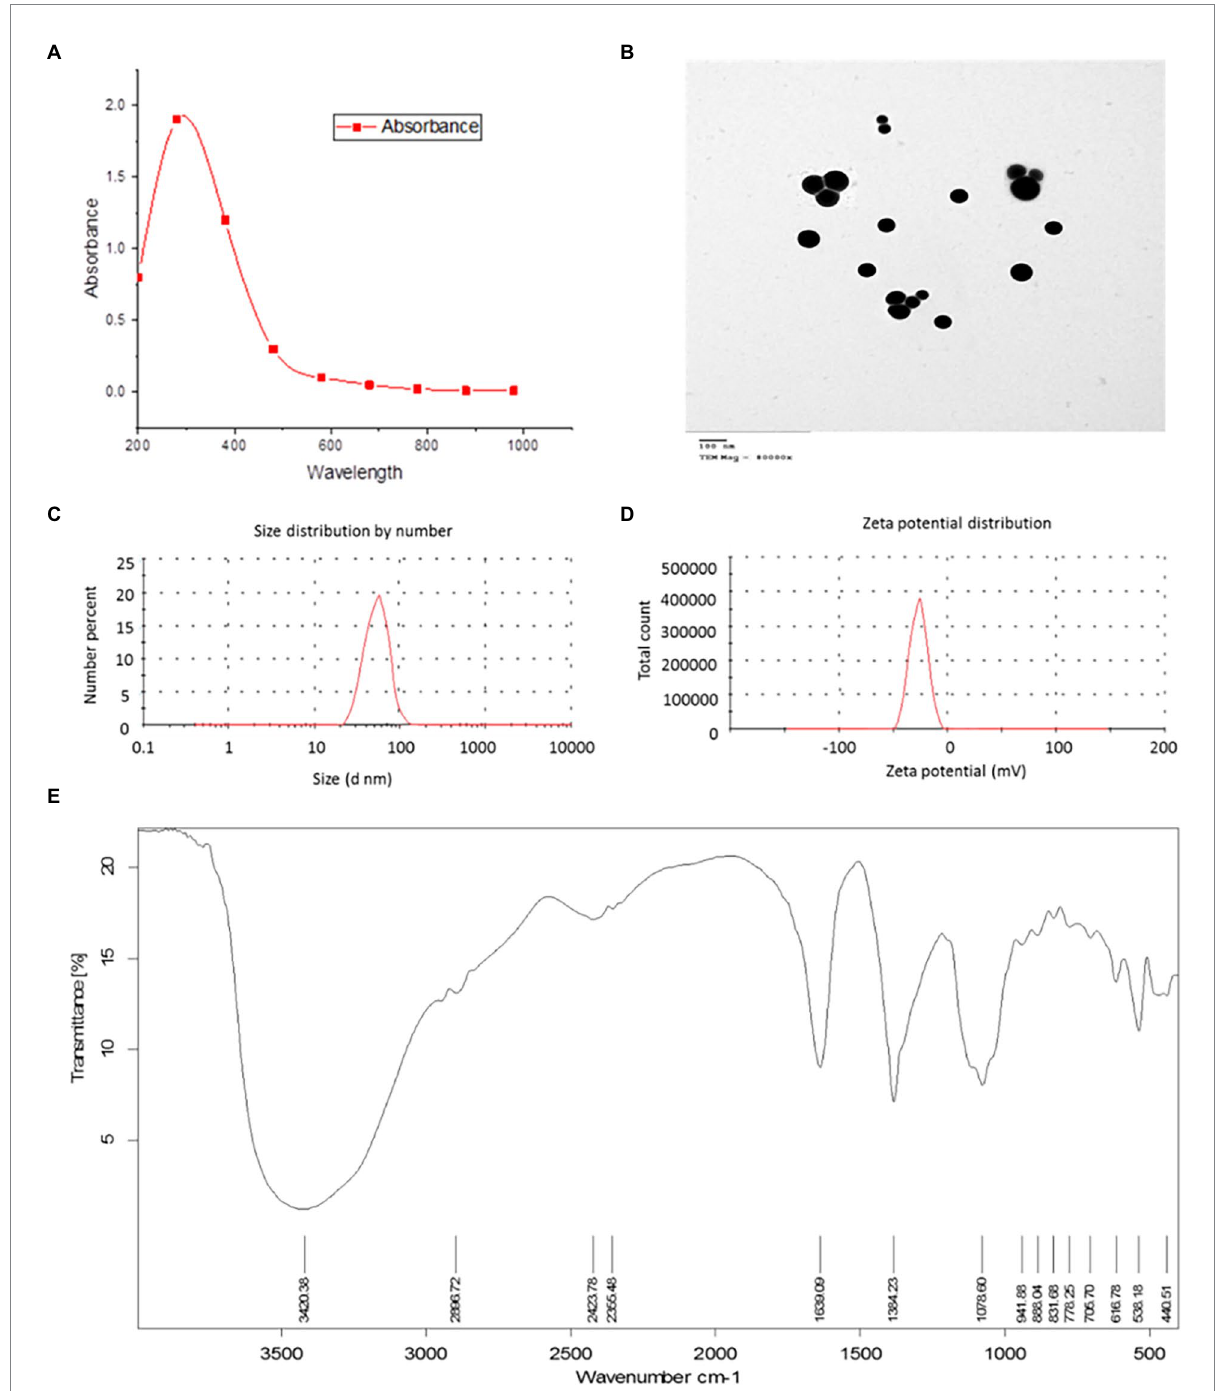
FIGURE 3 Characterization of biosynthesized selenium nanoparticles (BioSeNPs) synthesized by Bacillus subtilis AS12. (A) U.V. absorbance at 280 nm; (B) the size of 25–67 nm and its spherical shape in a transmission electron micropscopic image; (C) average size of 77.78 nm by Zeta sizer; (D) surface net negative charge by Zeta potential ( − 26.4); and (E) Fourier transform-infrared (FTIR)